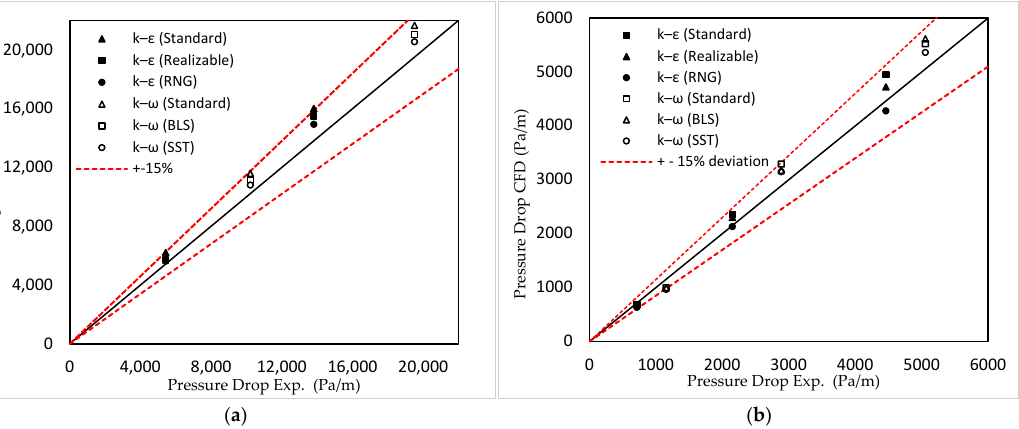
Figure 13. Comparison of frictional pressure drops obtained from CFD model vs. experimental data. ( a ) CMC4 power-law fluid pipe diameter 19.1 mm. ( b ) CMC4 power-law fluids pipe diameter 76.2 mm.